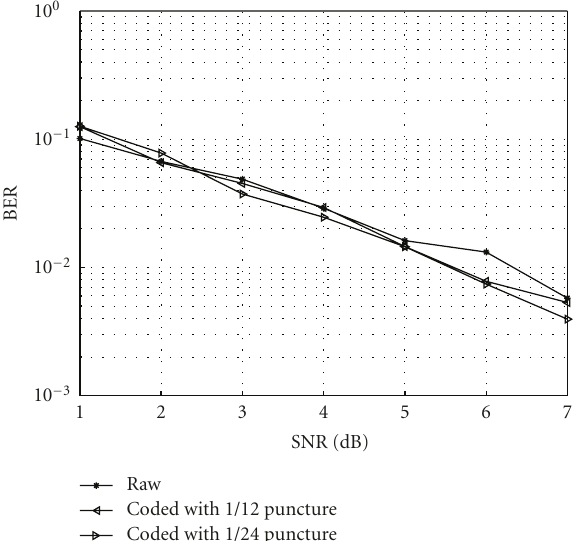
Figure 8: Average BER versus E b /N 0 for LO-MAC in Rician fading channel ( K = 200 dB, f d =